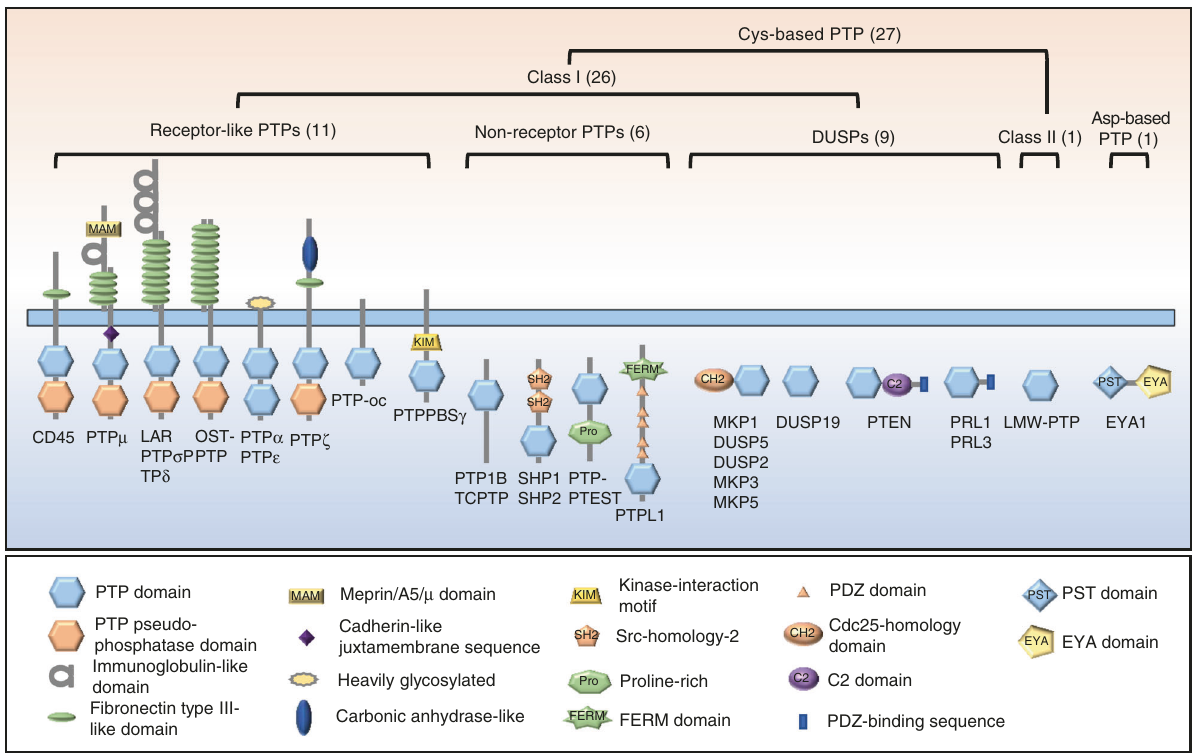
Fig. 3 Schematic diagrams depicting the structures of 28 PTPs that are covered by this review and involved in skeletal development and diseases. Most PTPs belong to the Cys-based class I PTPs, which are further classi fi ed into receptor-like PTPs (RPTPs), nonreceptor PTPs (NRPTPs), and DUSP groups. Only one PTP (LMW-PTP) belongs to Class II; one PTP belongs to Asp-based PTPs. The diagrams were adapted from ref. 15